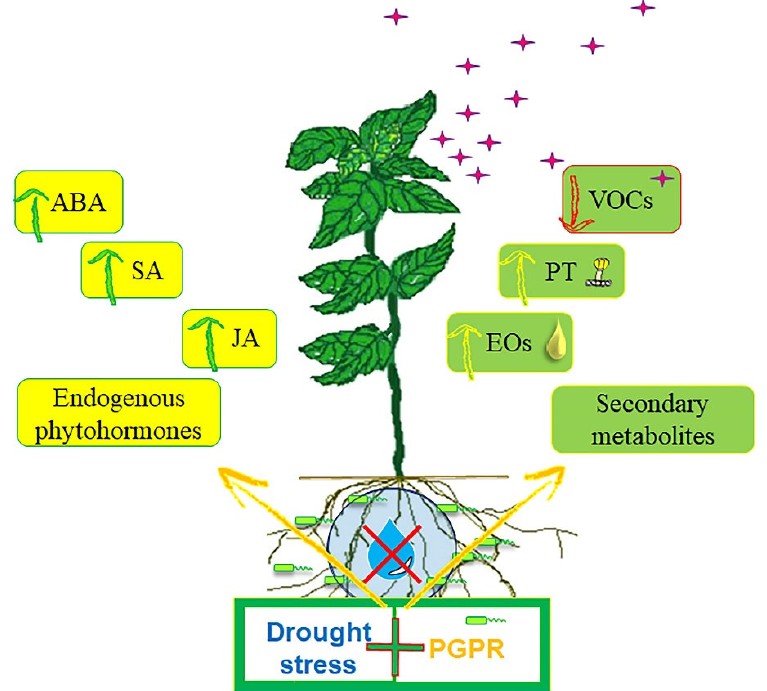
Figure 6. Schematic plant responses involved in Mentha piperita subjected to drought stress and treated with PGPR. Under these conditions, a rise in endogenous phytohormone levels (SA, JA, ABA) was observed as well as an increment in EO yield and PT density compared to regularly watered plants. In contrast, VOC emissions were reduced. EO: Essential Oil, VOC: Volatile Organic Compounds, PT: Peltate Trichome; JA: Jasmonic Acid; SA: Salicylic Acid and ABA: Abscisic acid; PGPR: plant growth promoting rhizobacteria.